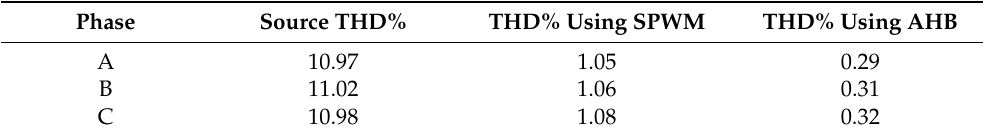
Figure 10. The simulation results of the voltage swell ( a ) Source voltage, ( b ) injected voltage, ( c ) load voltage. Table 5. The voltage THD for the case of voltage